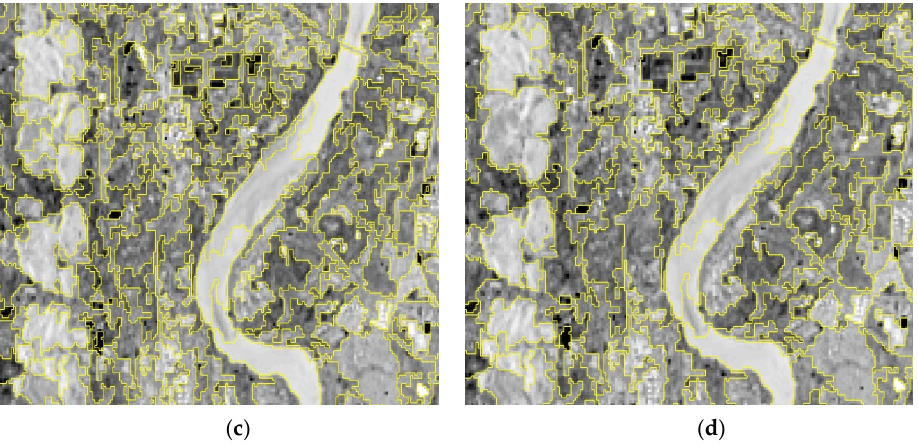
Figure 12. Di ff erent scale-segmentation e ff ects based on features fusion image. ( a ) Scales 15; ( b ) scales Figure 12. Different scale-segmentation effects based on features fusion image. ( a ) Scales 15; ( b ) 25; ( c ) scales 35; ( d ) scales 50. scales 25; ( c ) scales 35; ( d ) scales 50.